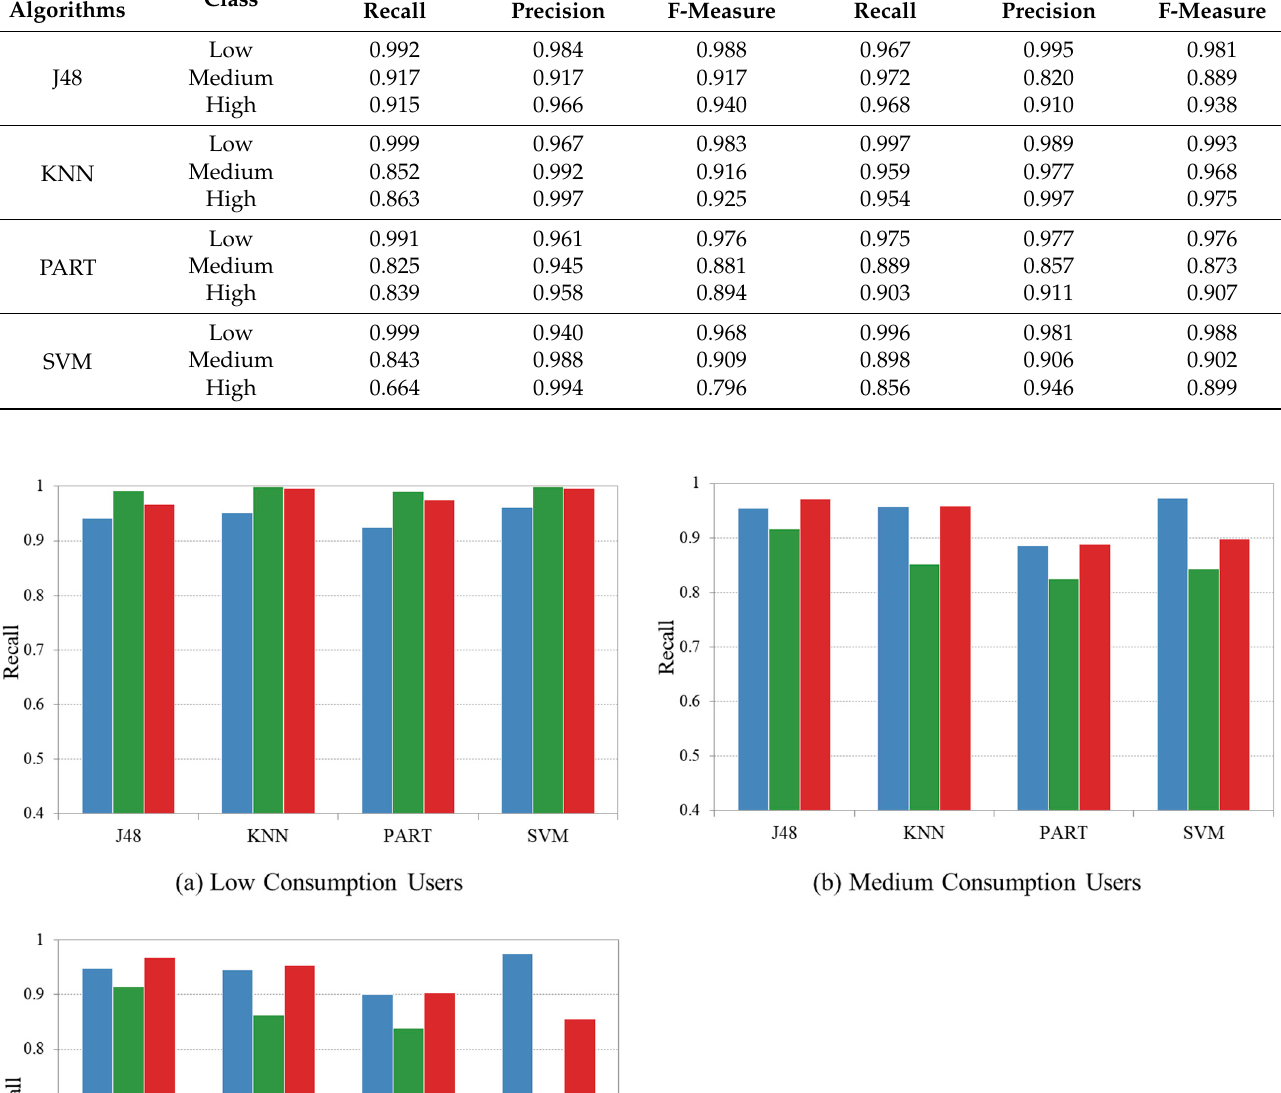
Table 4. Performance comparison between conventional methods and our framework in an imbalanced data environment. ML